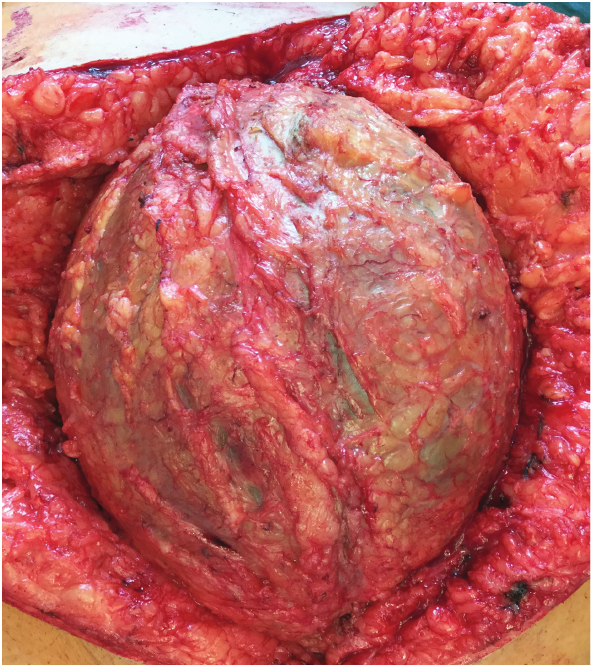
Figure 3: Excision of the encapsulated seroma in progress